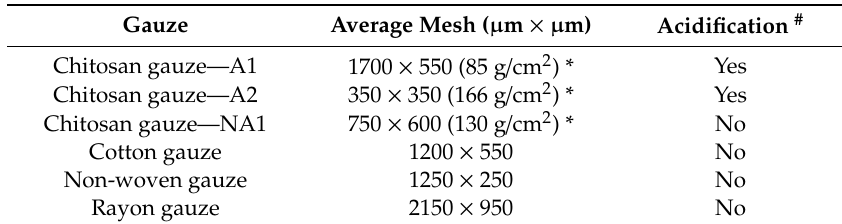
Table 1. Gauzes in this